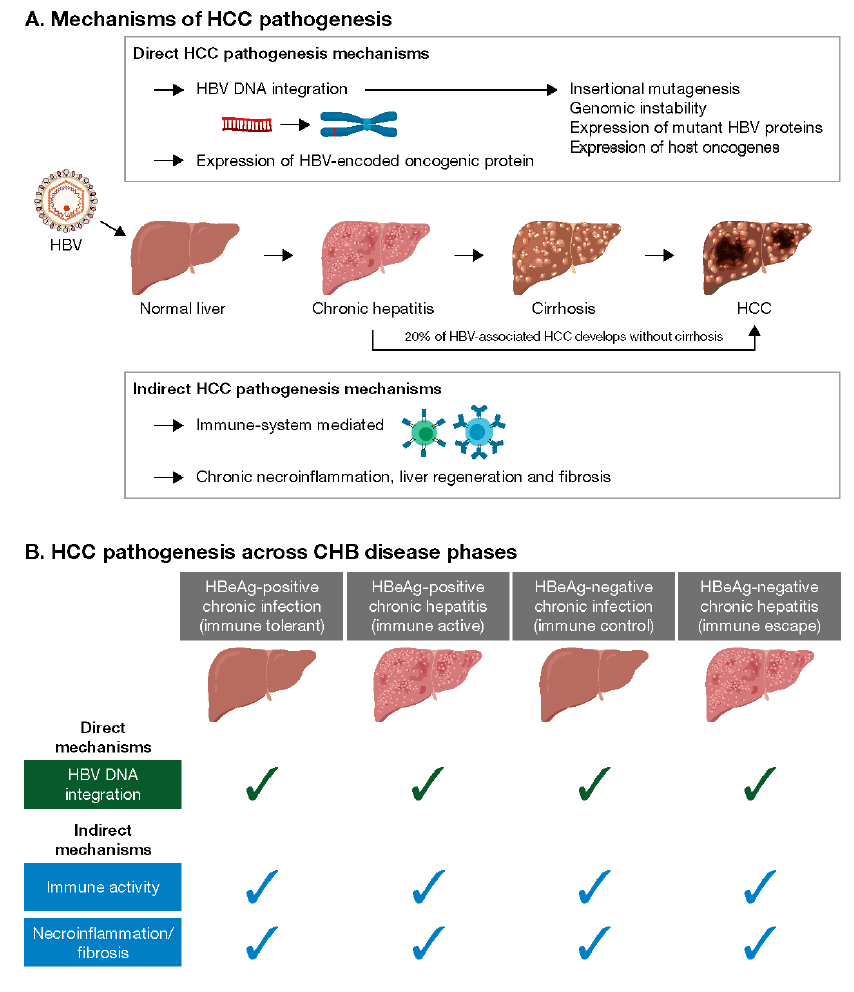
Figure 1. HCC pathogenesis. These schematics summarize some of the key HCC pathogenesis mechanisms in CHB patients ( A ) and in which CHB disease phases these have been detected ( B ). ( A ) HBV infects normal liver hepatocytes and can lead to CHB infection. During HBV infection, chronic hepatitis can develop, leading to cirrhosis and HCC in some patients. Approximately 20% of HBV-associated HCC cases develop in the absence of cirrhosis. HCC pathogenesis mechanisms can be direct or indirect. Direct HCC pathogenesis mechanisms are mediated by HBV and include HBV DNA integration into the host genome and the expression of HBV-encoded oncogenic protein. HBV DNA integration causes changes to the host genome via insertional mutagenesis, promoting genomic instability, and can lead to the expression of mutant HBV proteins. Indirect HCC mechanisms are mediated by the host immune system attacking HBV-infected hepatocytes. This leads to chronic necroinflammation, liver regeneration, and fibrosis, which cause genetic and epigenetic changes within hepatocytes. ( B ) Several studies have shown that HBV DNA integration into the host genome can be detected in liver samples from CHB patients across disease phases. Immune activity against HBV can also be detected in CHB patients across disease phases, as can necroinflammation and fibrosis in some patients. CHB, chronic hepatitis B; HBeAg, hepatitis B envelope antigen; HBV, hepatitis B virus; HCC, hepatocellular